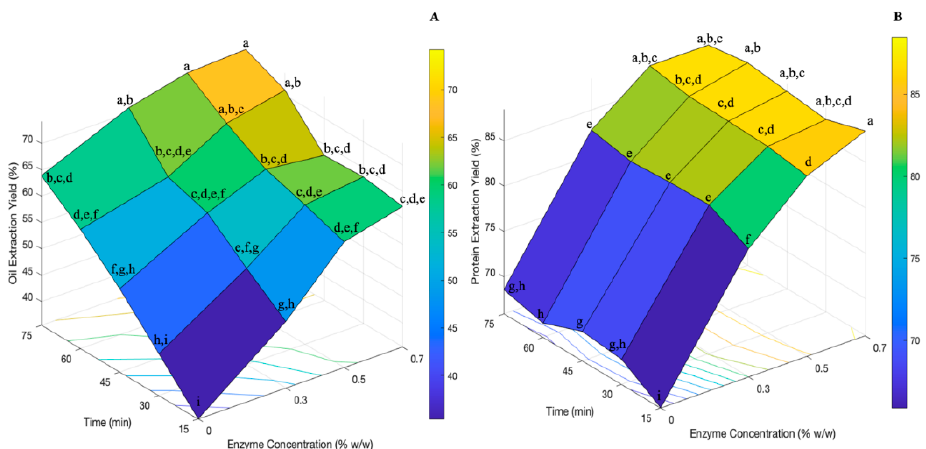
Figure 2. Total oil ( A ) and protein ( B ) extraction yields at each time point and enzyme concentration. Different letters indicate statistically significant differences by a two-way ANOVA followed by Tukey’s test at p < 0.05.